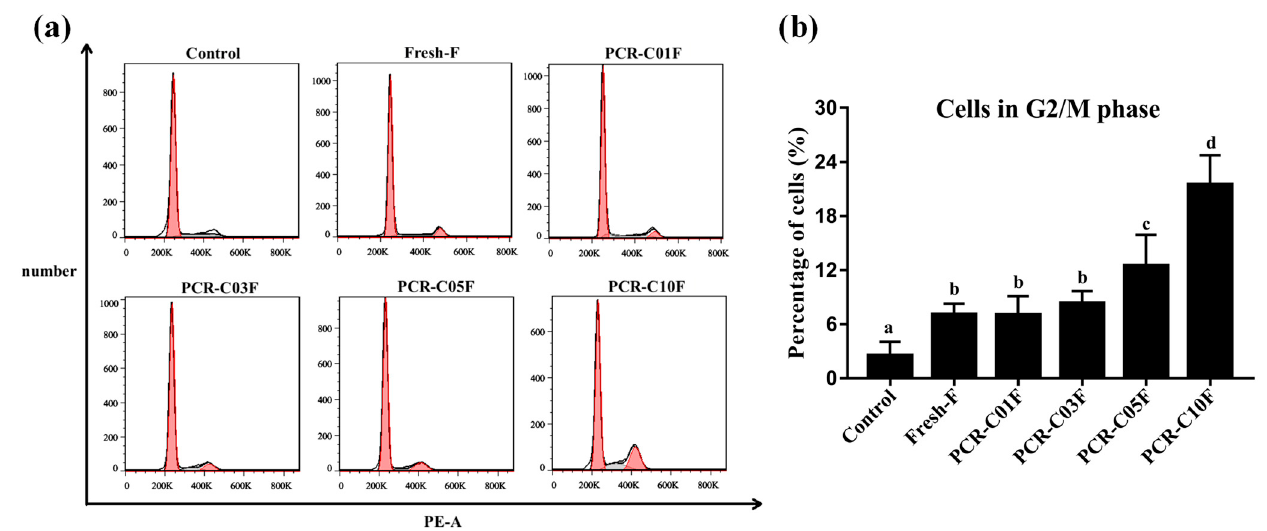
Figure 4. PCR-CF-induced G2/M phase cell cycle arrest in A549 cells. ( a ) The effect of PCR-CF on cell cycle distribution of A549 cells. Fluorescence intensity of A549 cells with or without 24-h PCR-CF (200 µ g/mL) treatment by PI staining was measured by flow cytometry. ( b ) Percentage of cells at G2/M phase of cell cycle. The data were expressed as the means ± SD of the triplicates of each independent experiment. The different lowercase letters above the bars indicated a significant difference ( p < 0.05) between the different groups through one ‐ way ANOVA and Duncan’s multiple comparisons.